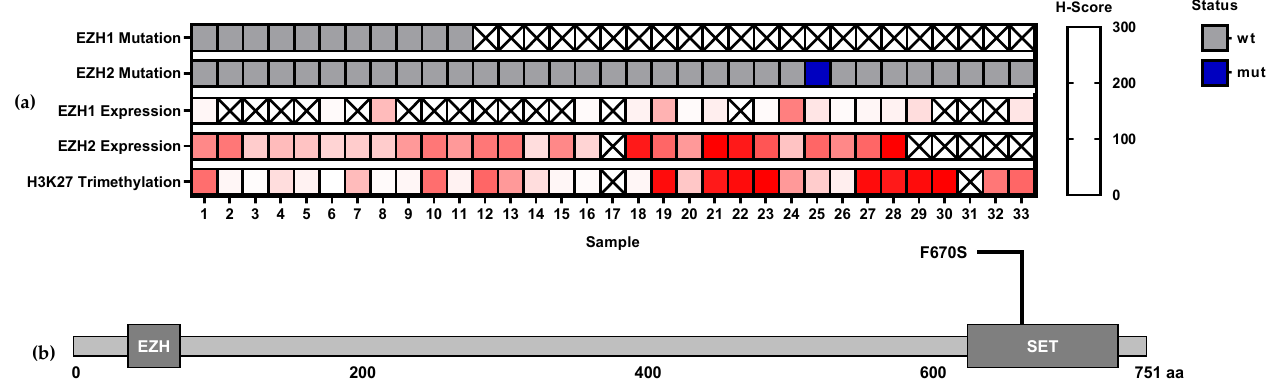
Figure 1. EZH1 and EZH2 mutations in monomorphic epitheliotropic intestinal T-cell lymphomas (MEITL): ( a ) EZH1 and EZH2 mutations and its association with EZH1, EZH2 and H3K27m3 protein expression. ( b ) Localization of the EZH2 mutation in the SET-domain. Abbreviations: wt — wild type; mut — mutation.